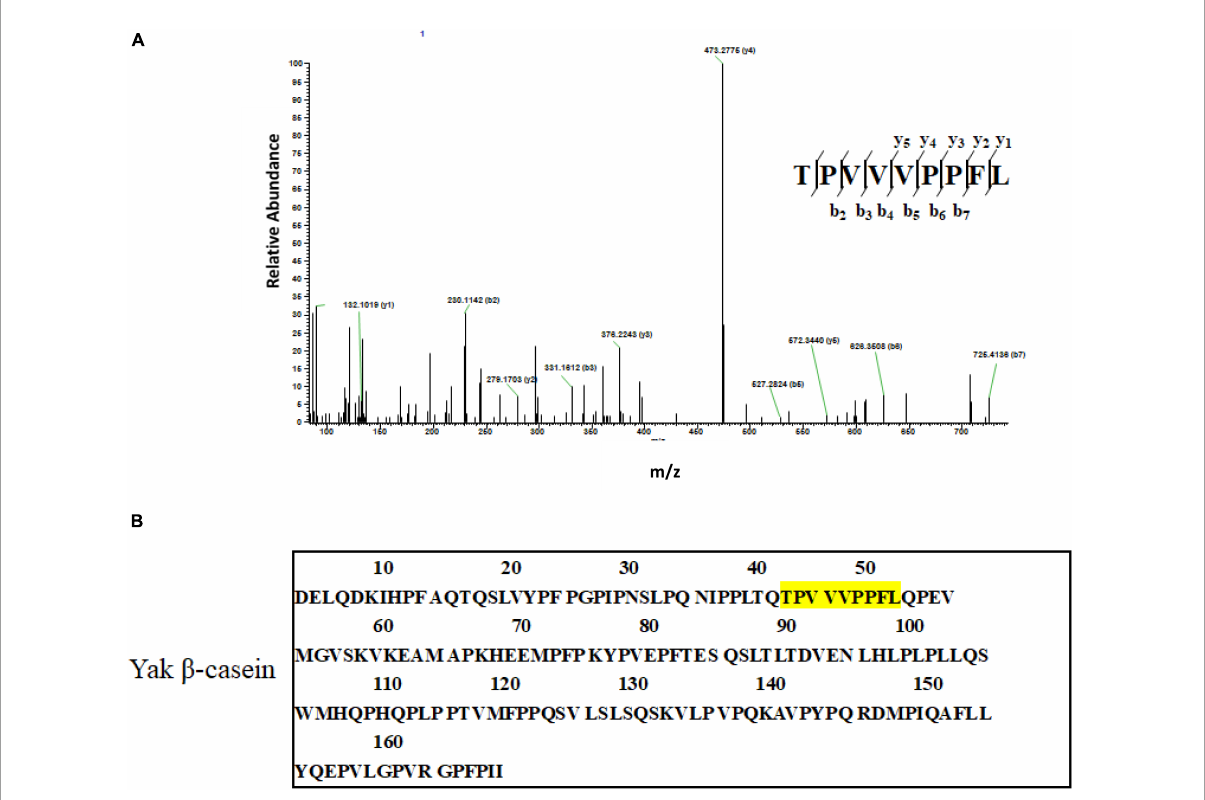
FIGURE4 Identification of anti-breast cancer cells peptides. (A) LC-ESI MS/MS spectrum of the double-charged ion with m/z 510.2713. The spectrum fitted to TPVVVPPFL. (B) The primary structure of yak β -casein (UniProt KB number H2DZG3) and potential anti-cancer peptides identified in the yak casein hydrolysate fractions are colored